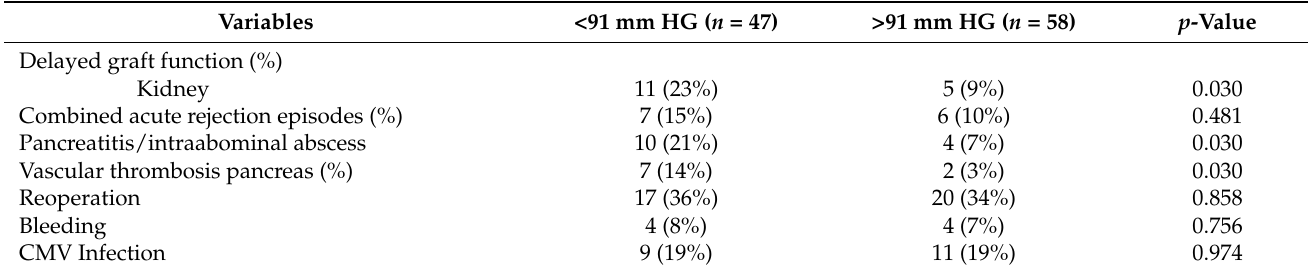
Table 3. Postoperative complications after simultaneous pancreas–kidney transplantation.